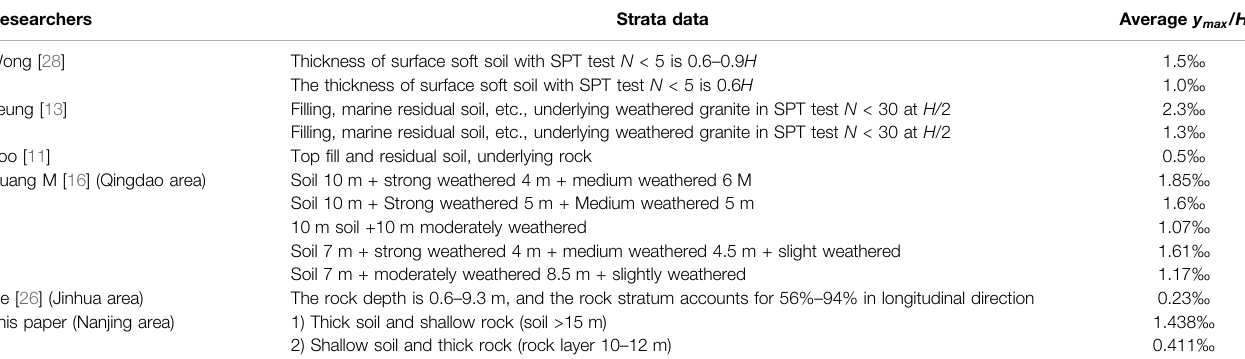
TABLE 3 | Statistics of Horizontal Displacement of Rock-socketed Piles by scholars. Researchers